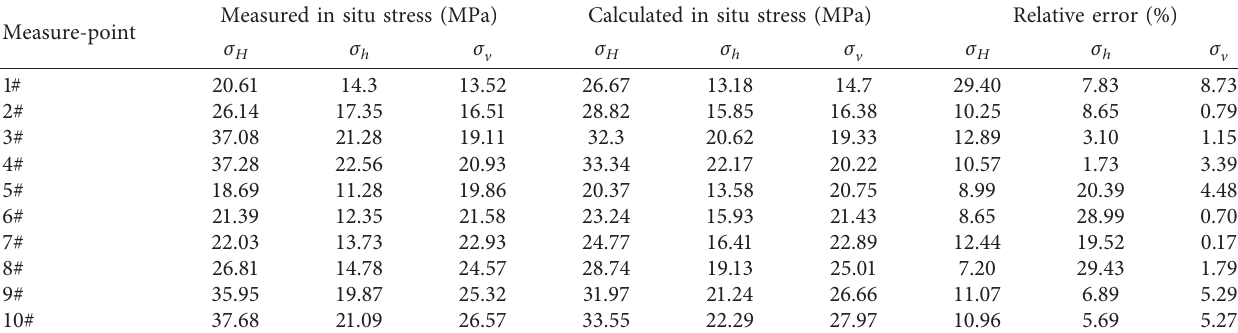
Table 4: Comparison between measured and calculated in stress values of the tunnel in Sichuan-Tibet Railway.